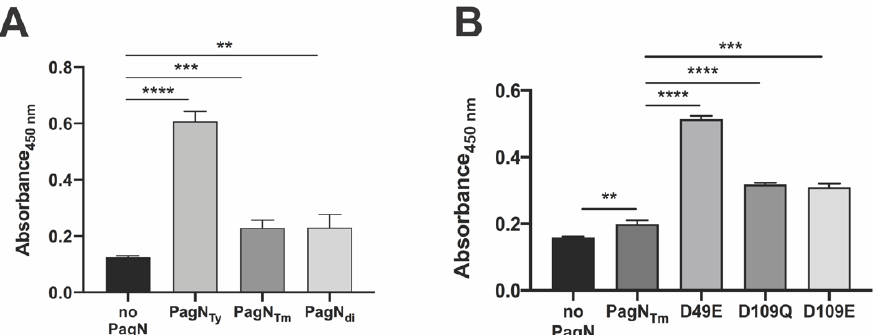
Figure 5. Binding of PagN allelic variants to murine laminin. ( A ) The PagN Ty -expressing bacteria bound best to laminin. E. coli AAEC189 expressing PagN Tm , PagN Ty , PagN di or containing empty vector (no pagN ) were incubated with microtiter wells coated with murine laminin. Bacterial binding was detected by an ELISA-method with anti-PagN antiserum. ( B ) All substitution mutants bound better to laminin than bacteria expressing PagN Tm , with the mutant expressing glutamic acid at position 49 of PagN Tm (D49E) binding best ( p < 0.0001). Data represent one of three separate and reproducible experiments, each with triplicate data expressed as mean ± SEM (** p < 0.01, *** p < 0.001 and **** p < 0.0001).